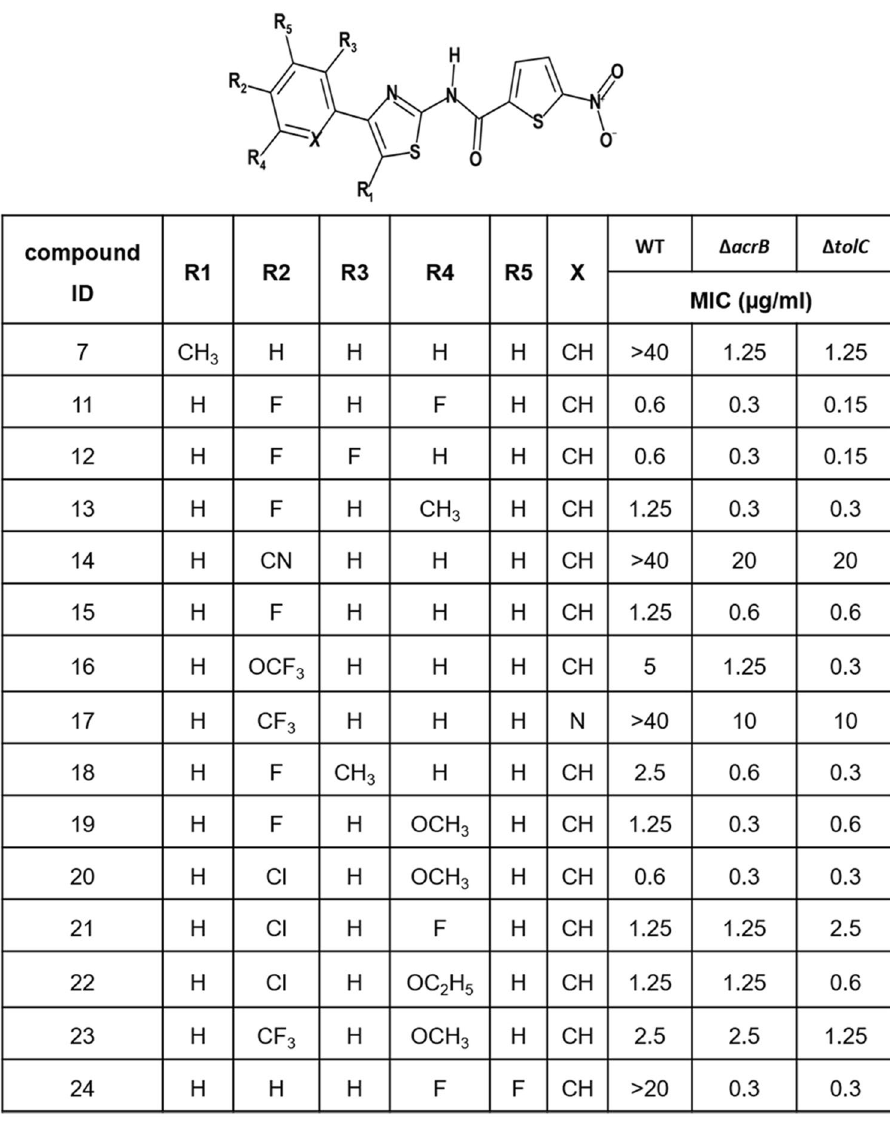
Figure 2. SAR of LHS ring with associated MICs on E. coli WT and pump